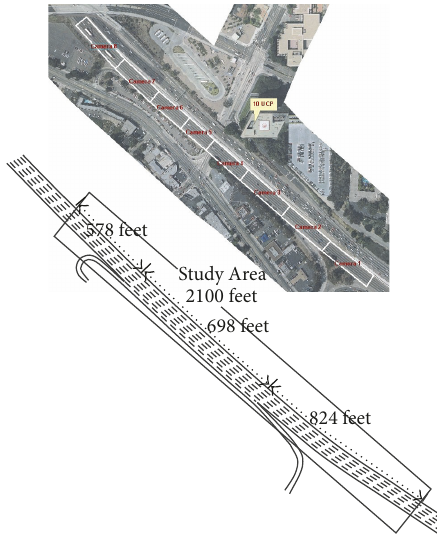
Figure 1: US Highway 101 study corridor from NGSIM